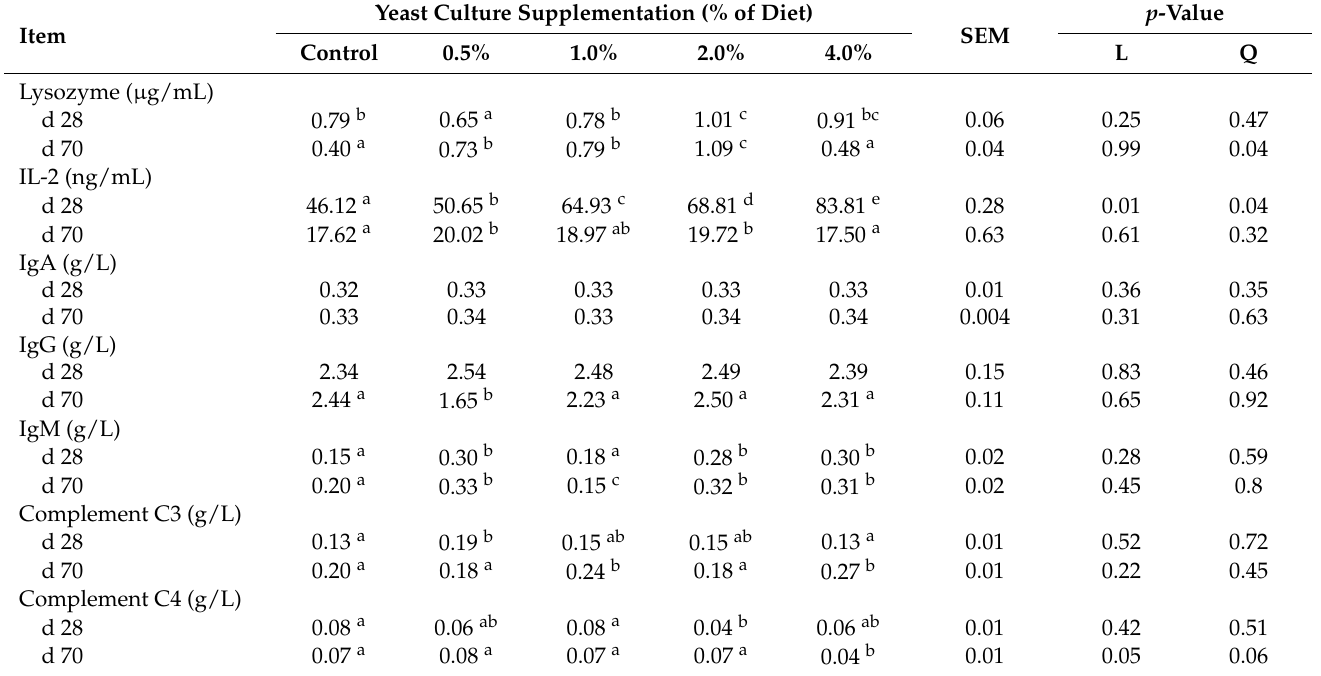
Table 6. Effect of yeast culture supplementation in goose diets on immune factors.